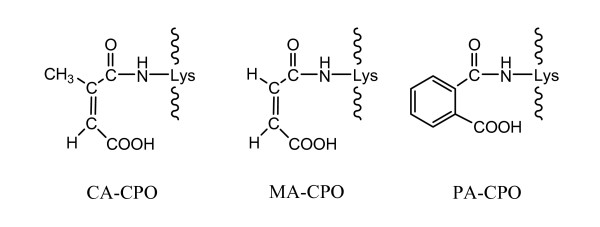
Modification of ε-amino groups of lysines of CPO.